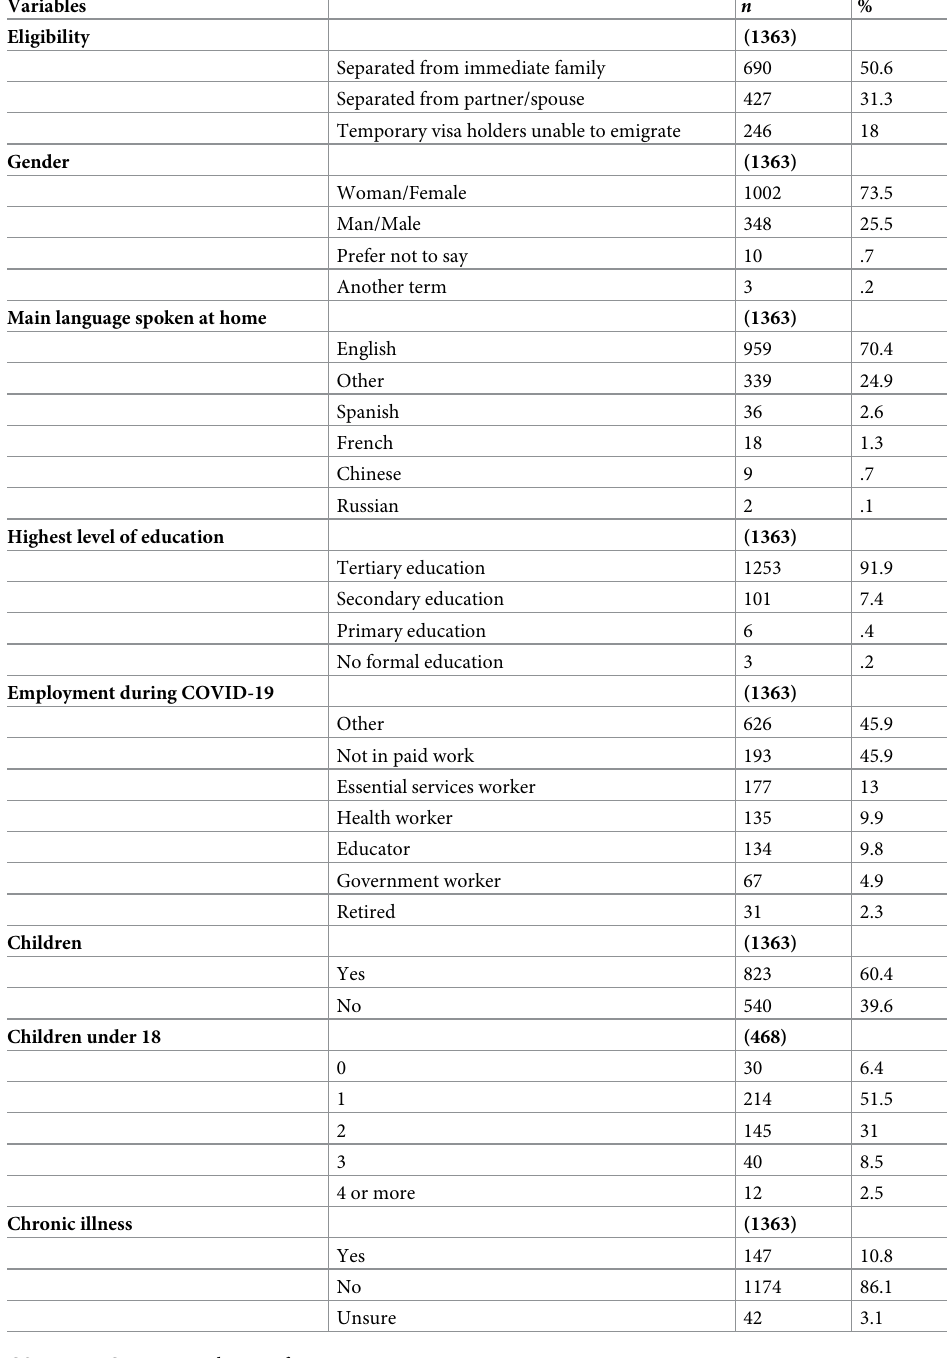
Table 2. Sociodemographic characteristics of temporary visa holders unable to immigrate and those separated from their partner or immediate family during